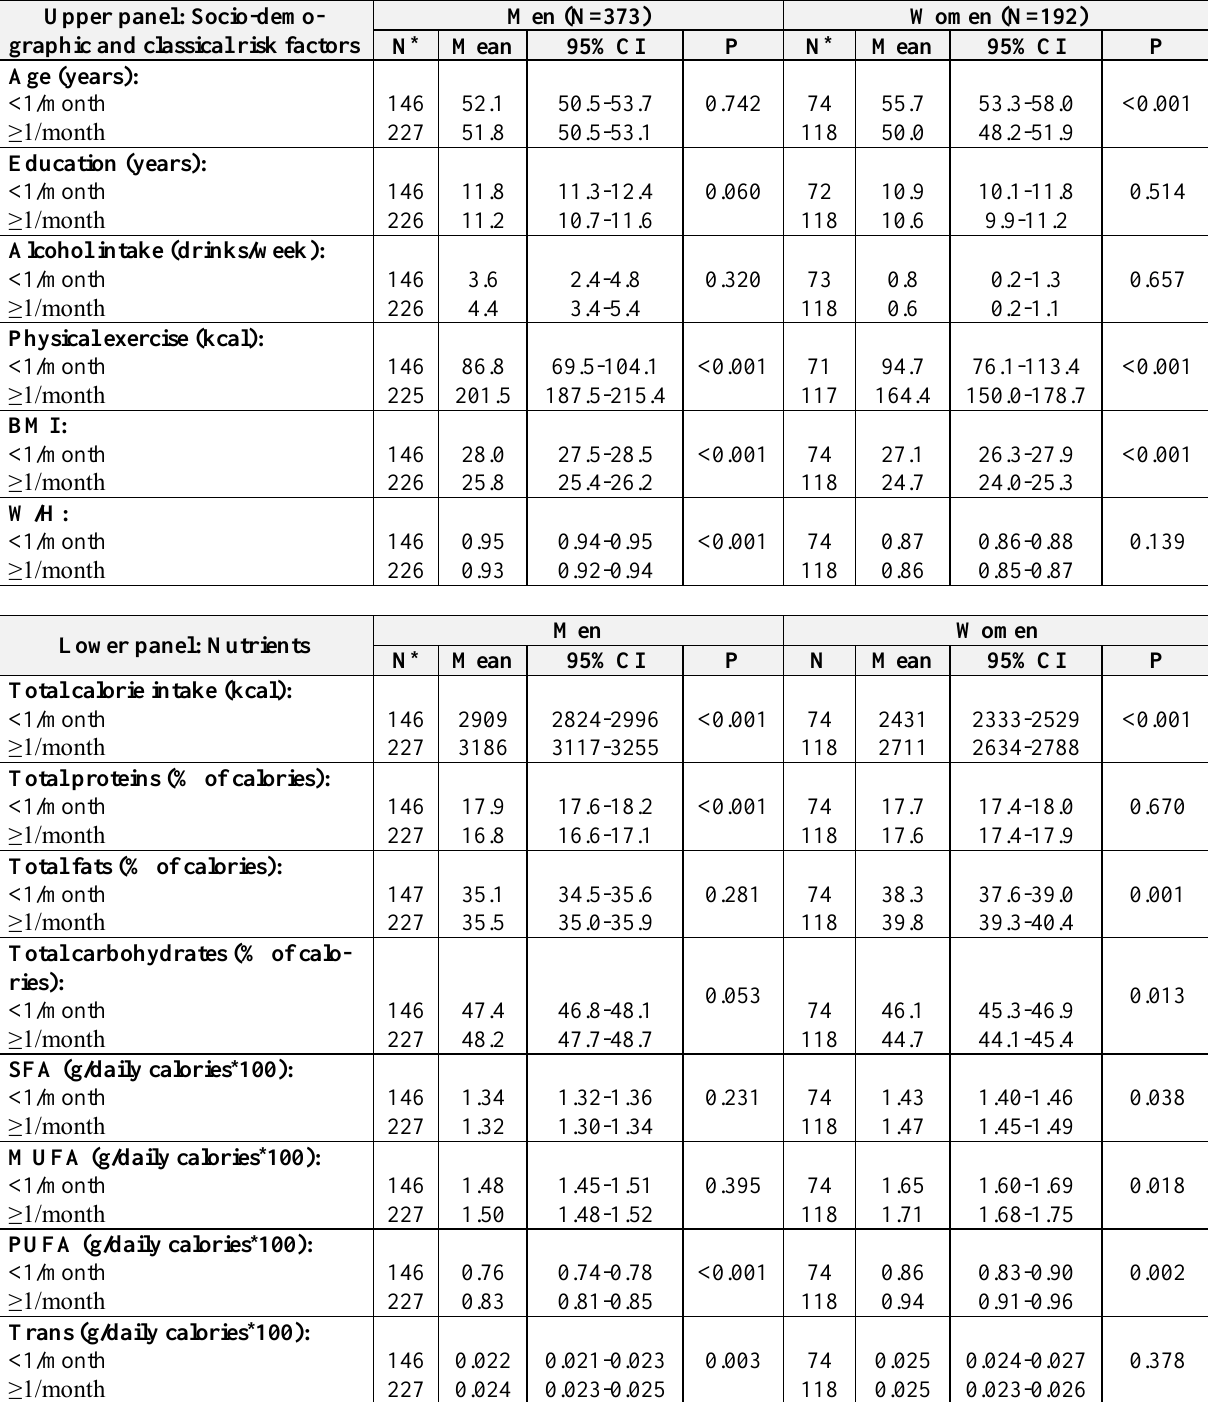
Table 1. Association of chocolate intake with socio-demographic characteristics, conven- tional risk factors and nutrient intake in a population-based sample of Albanian adults; age-adjusted mean values from general linear